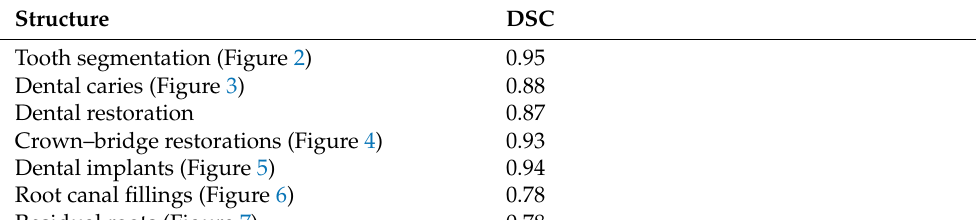
Table 1. The calculated Dice similarity coefficient values of teeth, dental caries, dental restoration, crown–bridge restorations, dental implants, root canal fillings, and residual roots segmentations.